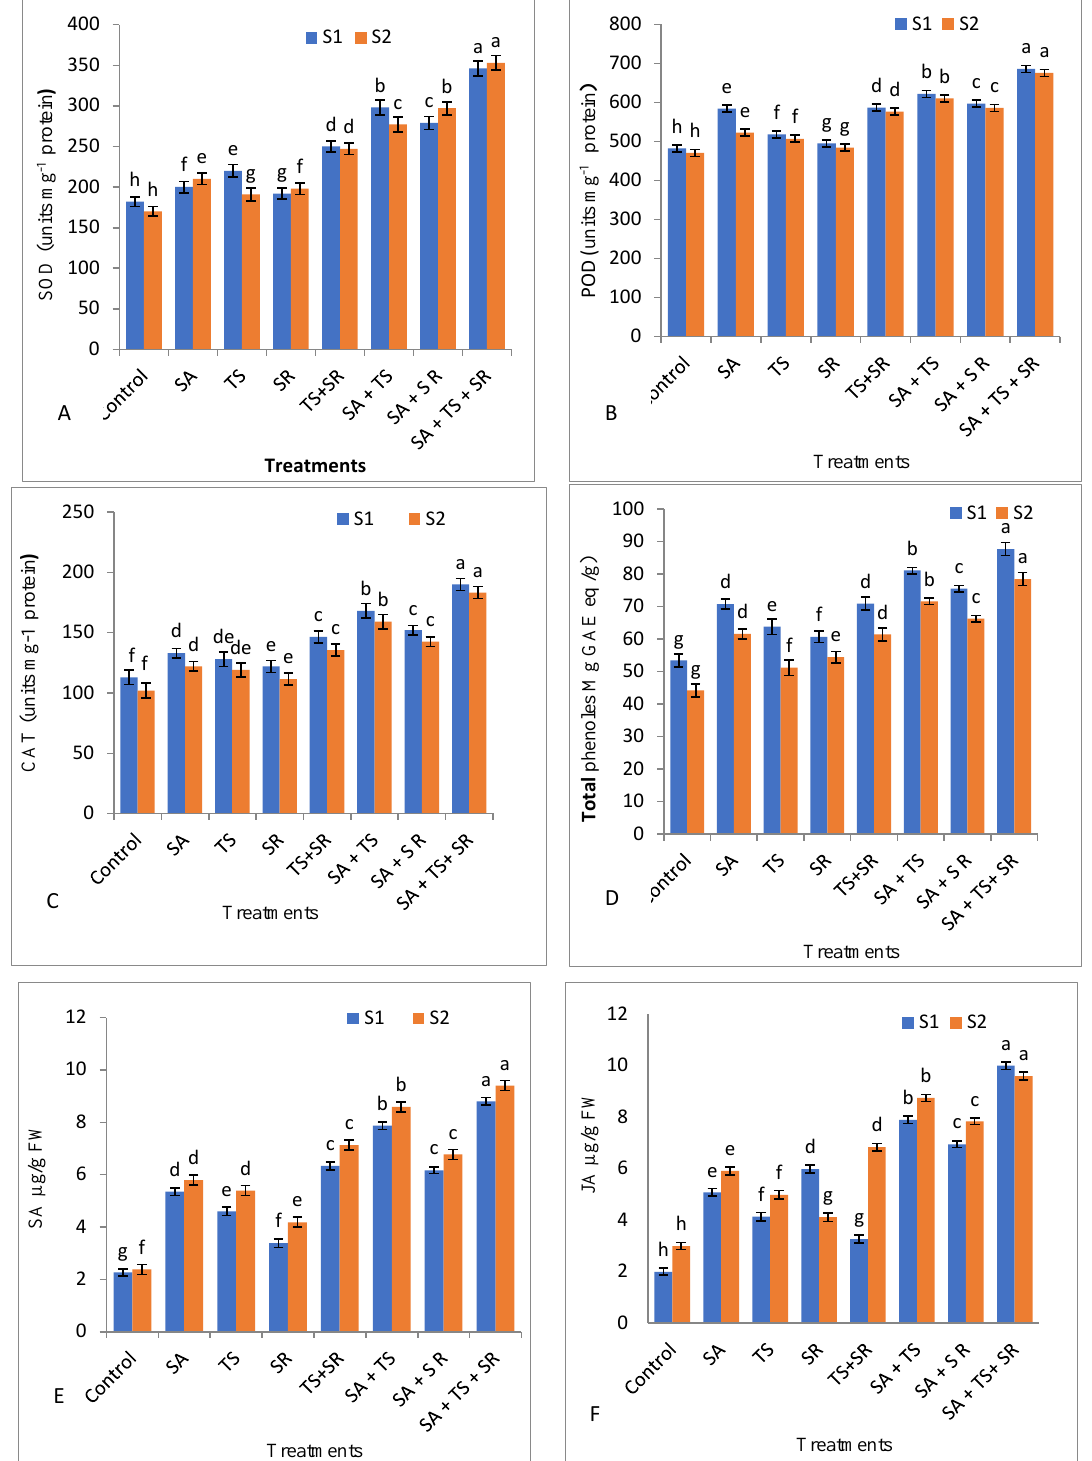
Figure 6. Effect of shikimic acid (SA) seed priming rates 40 ppm and foliar applications of water (control), T. asperellum (TS), S. rochei (SR), T. asperellum + S. rochei + (TS+SR), shikimic acid + T. asperellum(SA+TS), shikimic acid+ S. rochei (SA+SR), and shikimic acid + T. asperellum + S. rochei (SA+TS+SR) on ( A ) SOD, ( B ) POD, ( C ) CAT, ( D ) phenols, ( E ) SA, and ( F ) JA in leaves during two seasons . Standard errors of the mean are shown as vertical bars; the LSD test indicates that differences between values in each bar that are marked by different letters are significant at p ≤ 0.05.